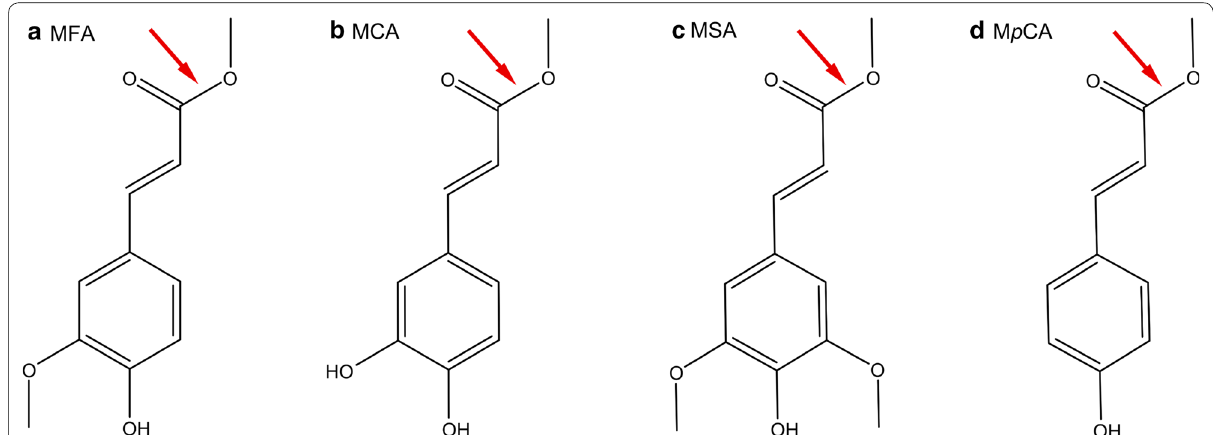
Fig. 1 Chemical structures of the four model substrates used to assess FAE activity. The arrows indicate the bond on which FAEs act. a Methyl ferulate (MFA), b methyl caffeate (MCA), c methyl sinapate (MSA), and d methyl p ‑coumarate (M p